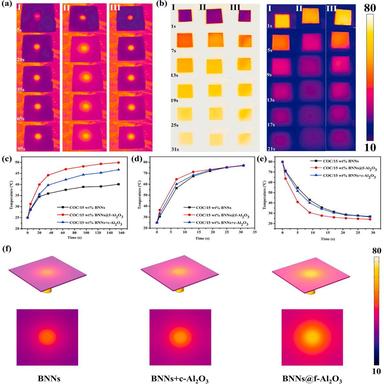
(I) COC/15 wt% BNNs, (II) COC/15 wt% BNNs@f-Al2O3, (III) COC/15 wt% BNNs + c-Al2O3. The infrared thermal images and average temperature variation of various composites under (a, c) point heating, (b, d) plate heating and (b, e) cooling process; (f) The infrared thermal imaging of various composites under point heating source simulated by COMSOL.